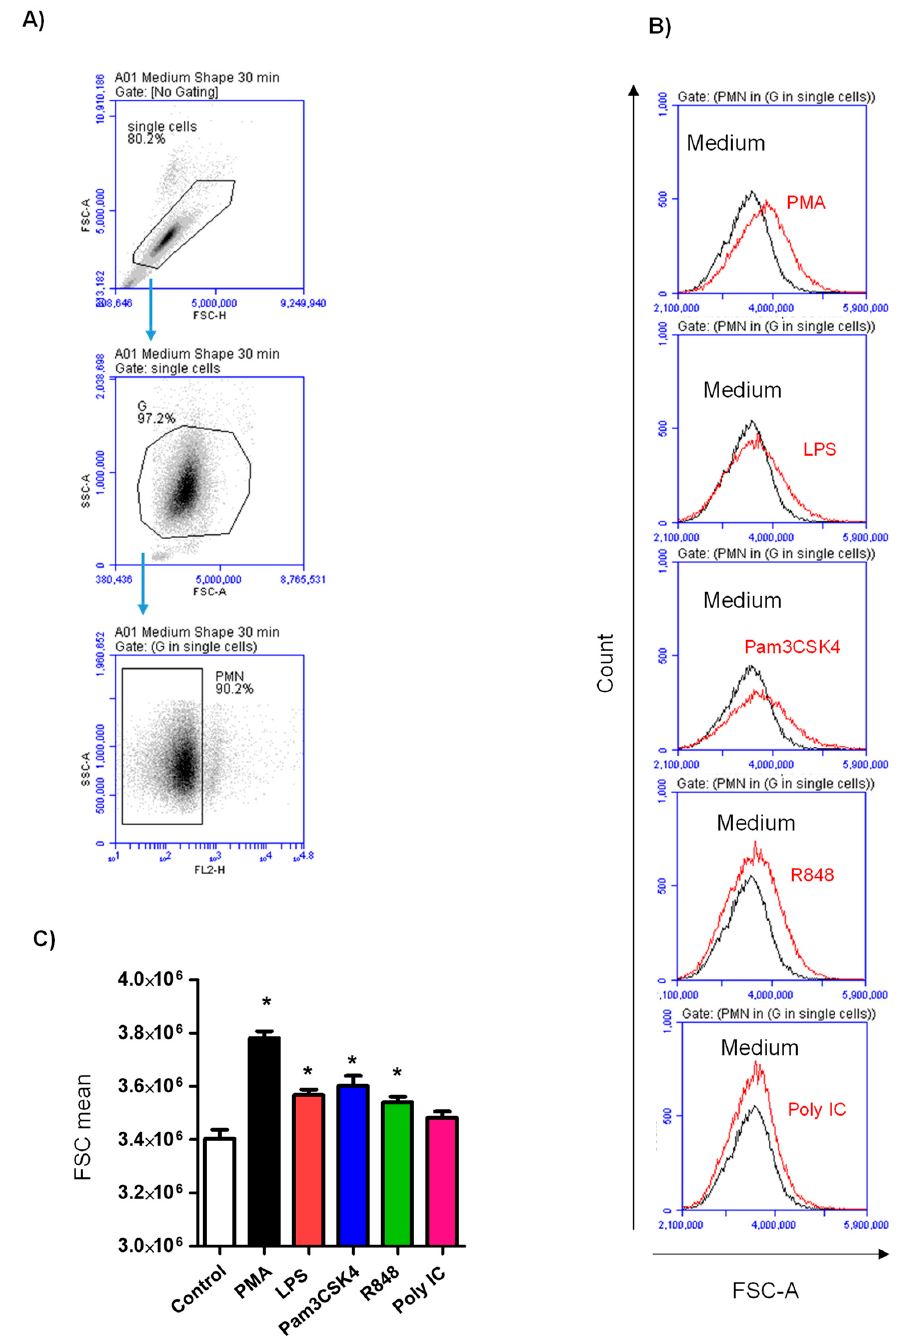
Figure 1. TLR stimulation-induced change in neutrophil cell size. ( A ) Single cells were identified in an FSC-H/FSC-A gate. Neutrophils (PMN) were identified within the granulocyte population (G) based on their lower auto-fluorescence in the FL-2 channel compared to eosinophilic granulocytes. ( B ) Overlapping histograms showing the change in FSC-A of stimulated neutrophils (red line) com- pared with control neutrophils (black lines). ( C ) Mean FSC-A values were calculated for control and stimulated neutrophils and presented graphically as mean and SEM. * indicates significant change in the FSC-A between the means of stimulated and non-stimulated cells with p values less than 0.05.